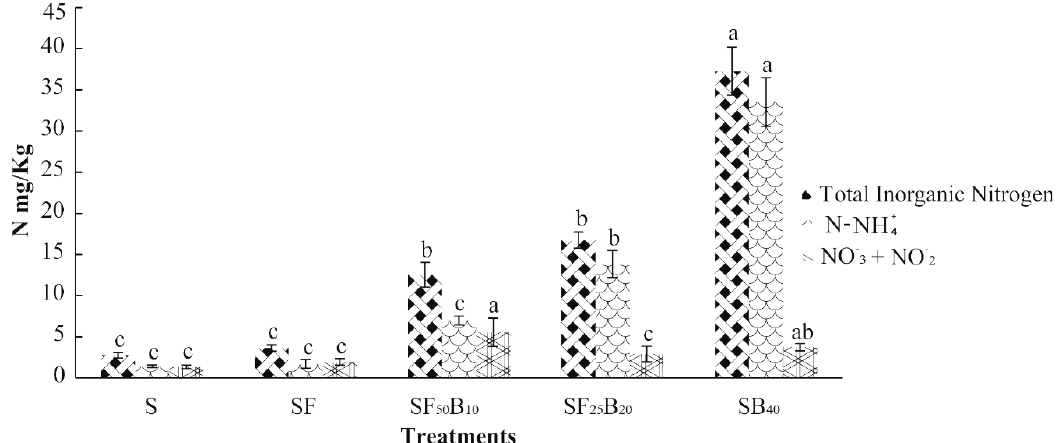
Figure 1. Nitrogen mineralization in S, soil without fertilizer (control); SF, soil + fertilizer (N:P:K 100:40:40); SF 50 B 10 , soil + fertilizer (N:P:K, 50:20:20) + biosolid (10 t ha −1 ); SF 25 B 20 , soil + fertilizer (N:P:K, 25:10:10) + biosolid (20 t ha −1 ) and SB 40 , soil + biosolid (40 t ha −1 ) after 10 days of treatment application. Means ± standard error, bars with different letters are significantly different according to the LSD test ( p < 0.05).